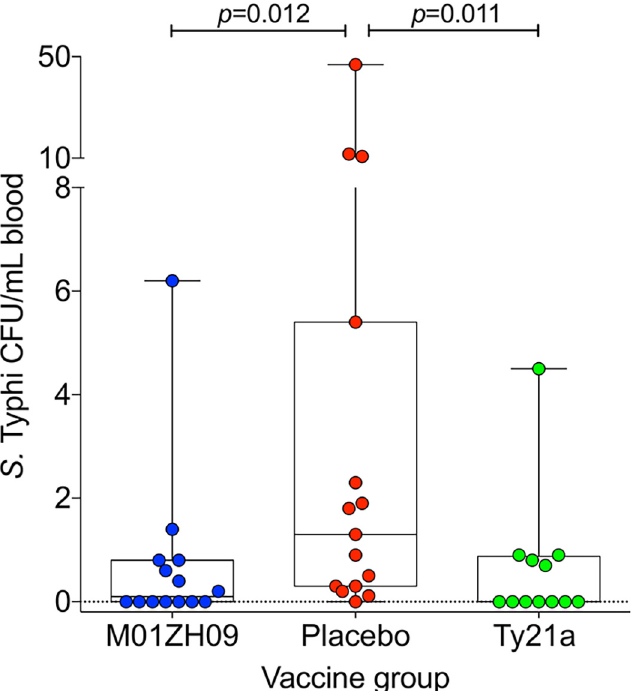
Fig 8. Blood quantification of Salmonella Typhi bacteria present at point of typhoid diagnosis by vaccine group. 10mL peripheral blood was collected at typhoid diagnosis (prior to antibiotic treatment) into an Isolator 10 tube (Wampole Laboratories). Lysis centrifugation was performed (30min x 3000G without brake) after which the deposit was plated to XLD and incubated aerobically at 37°C for 24 hours. After incubation, colony counts and slide agglutination tests were performed. P values calculated using Mann Whitney U test. Median [IQR] bacterial loads in CFU/mL were: M01ZH09 (n = 14): 0.13 [0.05 – 0.80]; Placebo (n = 15): 1.30 [0.30 – 5.40]; Ty21a (n = 12): 0.05 [0.05 – 0.99]. Lower limit of detection, 0.1 CFU/mL; zero values were substituted with LOD/2, i.e. 0.05